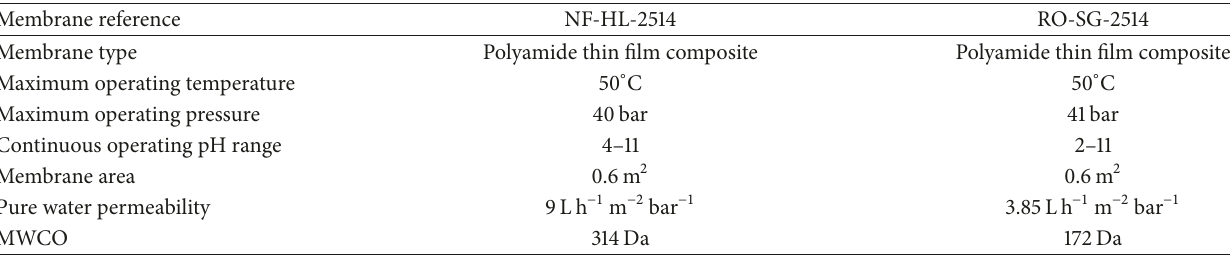
Table 1: Specifications of NF-HL-2514 and RO-SG-2514